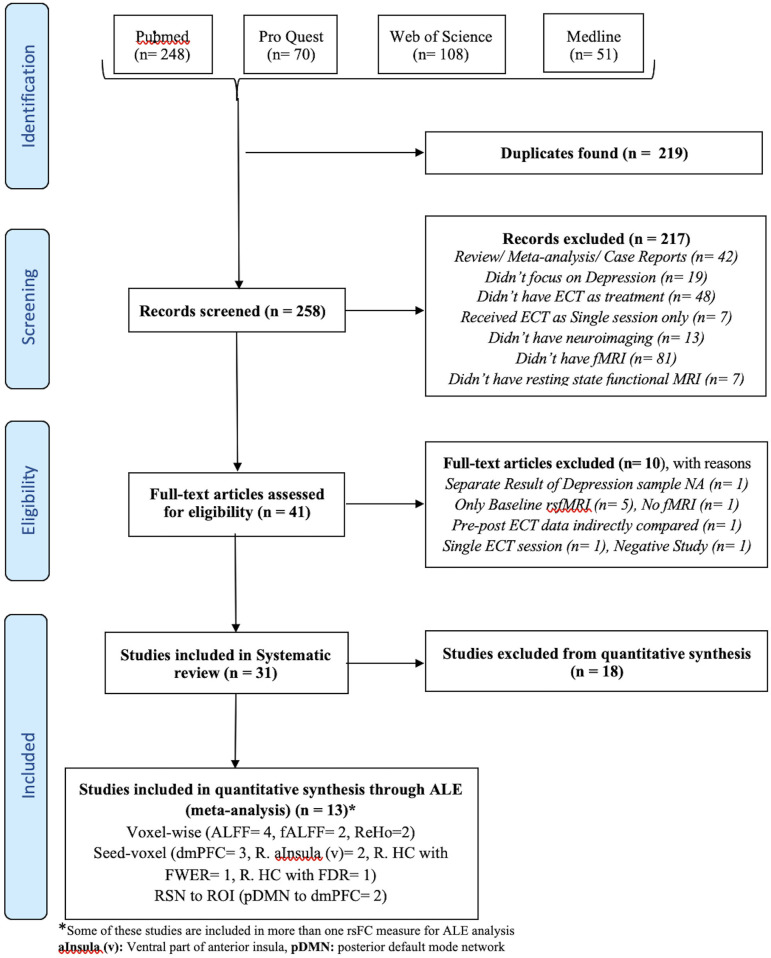
Flow diagram of literature search and study selection. *Some of these studies are included in more than one rsFC measure for ALE analysis. aInsula (v), Ventral part of anterior insula; pDMN, posterior default mode network.